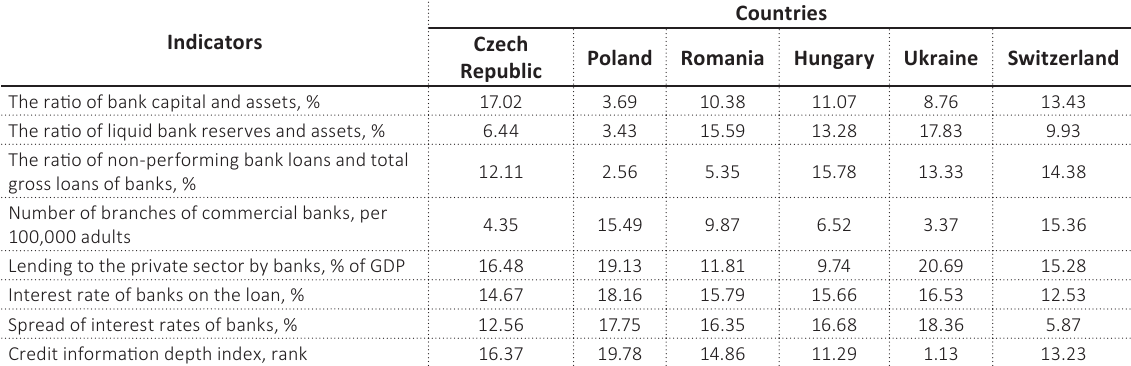
Table 1. Weight coefficients of indicators of banking sector development indices in some EU countries, Switzerland, and Ukraine,